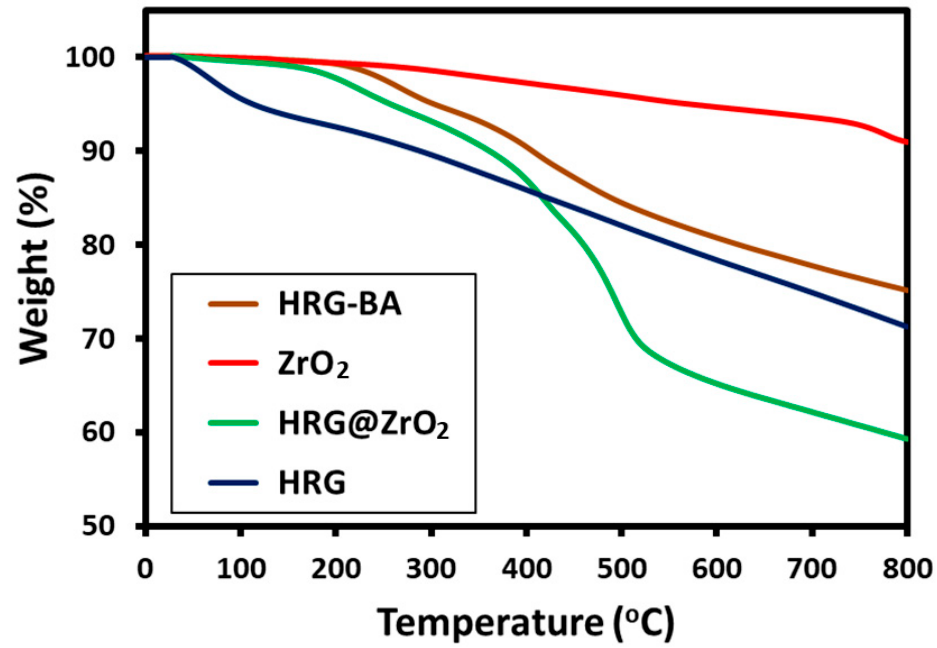
Figure 5. Thermogravimetric plot of ( a ) as-prepared ZrO 2 nanoparticles (red line) ( b ) HRG@ZrO 2 (green line), ( c ) HRG-benzyl alcohol (HRG-BA, brown line) and ( d ) HRG (blue line).